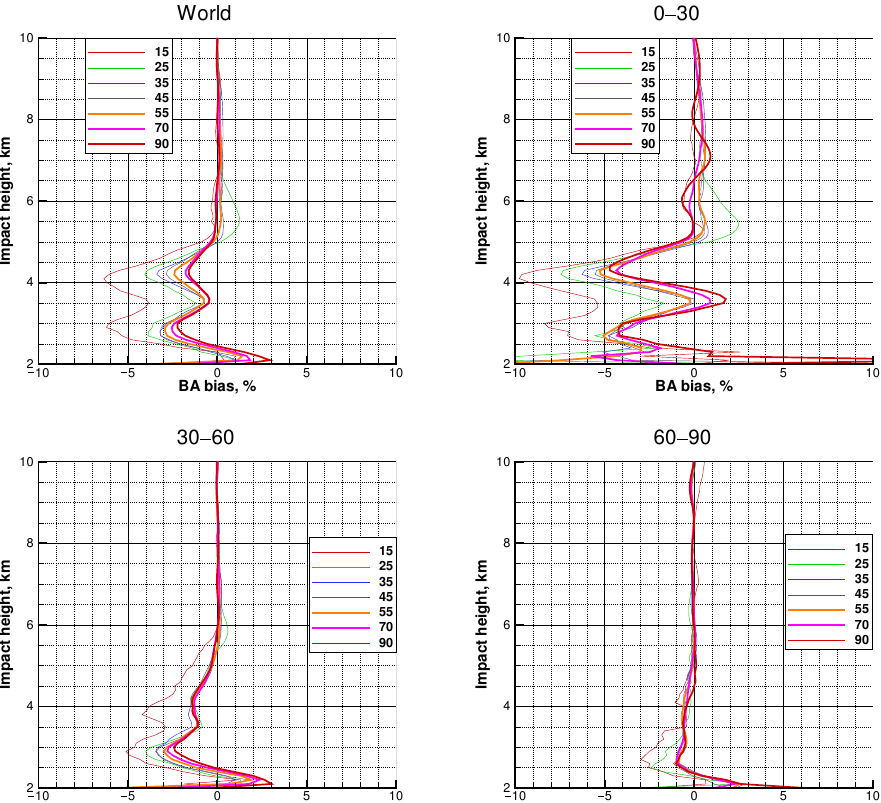
Figure 2. Statistical comparison of bending angles retrieved from RO observations with GFS analyses for different normalized SNRs. COSMIC, systematic difference, dynamic normalization. Upper left: world, upper right: tropics, lower left: middle latitudes, lower right: polar latitudes. All the latitude bins cover both North and South